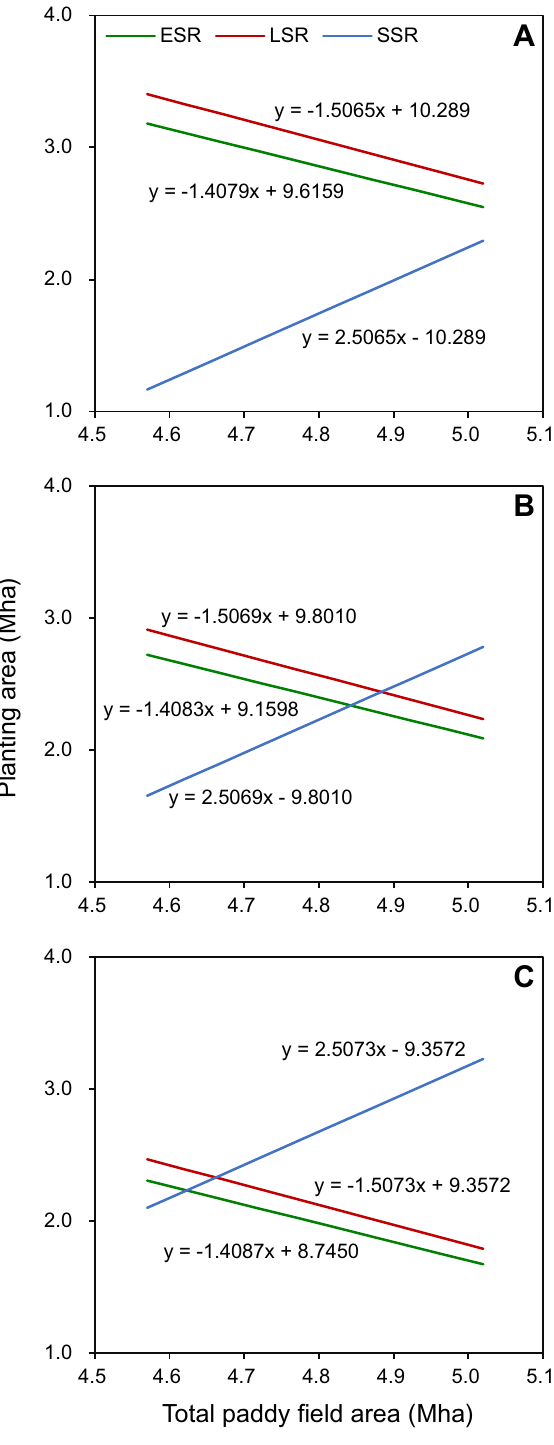
Figure 3. Estimated planting areas for early-season rice (ESR), late-season rice (LSR), and single-season rice (SSR) in the Hunan-Jiangxi region that will be required to achieve the expected rice production by 2030 under three scenarios: ( A ) constant yield scenario, ( B ) 5% yield increase scenario, and ( C ) 10% yield increase scenario. Mha is million